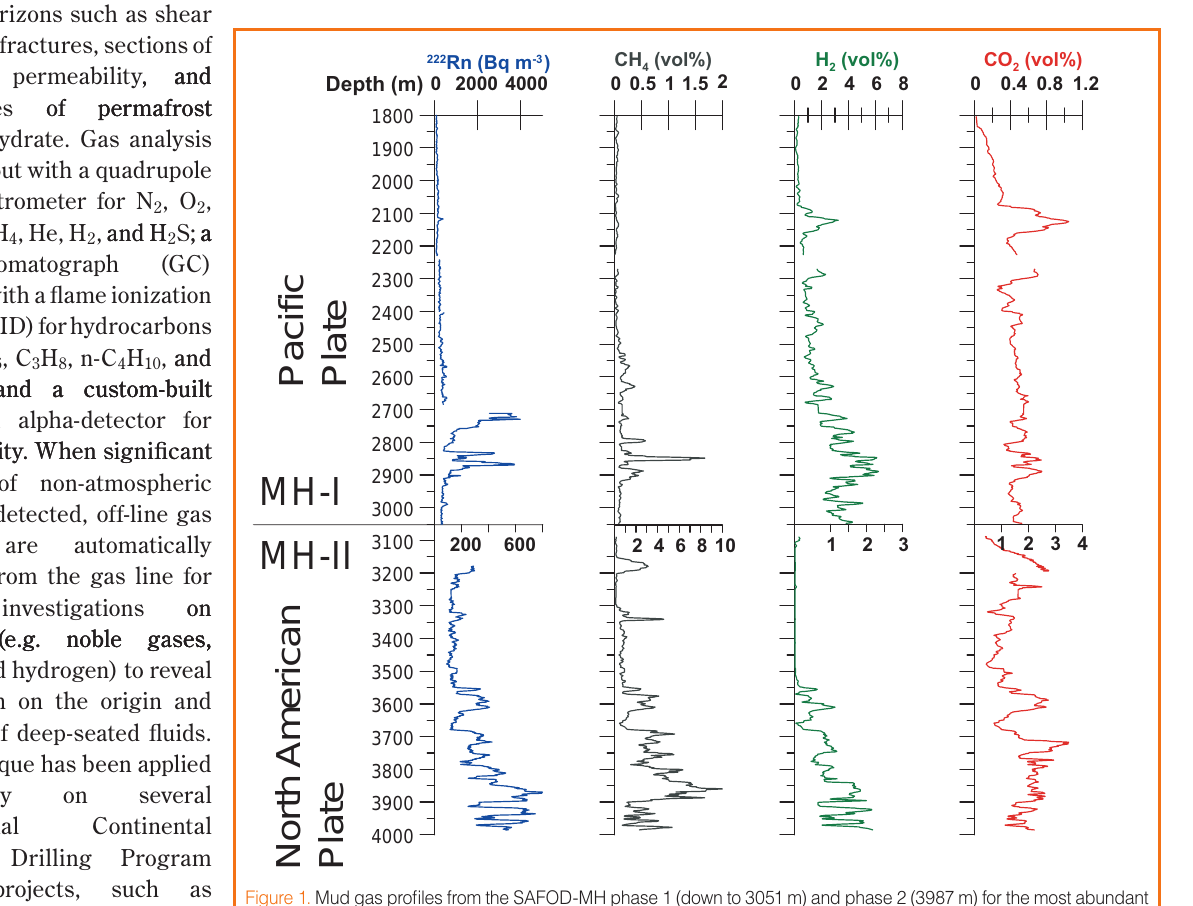
Figure 1. Mud gas profiles from the SAFOD-MH phase 1 (down to 3051 m) and phase 2 (3987 m) for the most abundant non-atmospheric